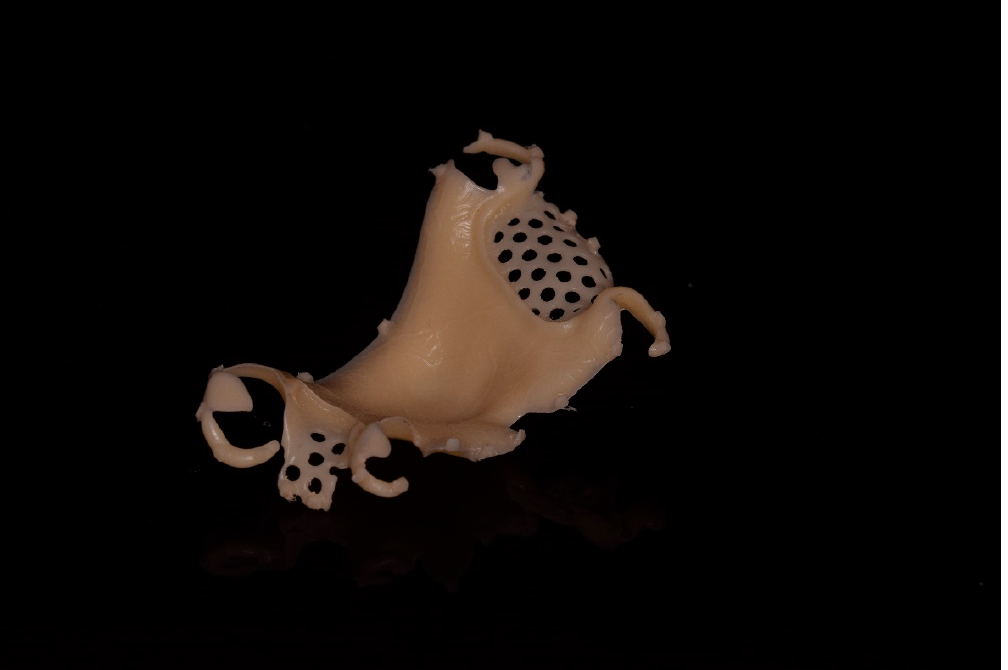
Figure 4. Acetal frameworks prior to finishing and polishing. Although rest seats were incorporated into the design, they are thin and do not provide adequate support.